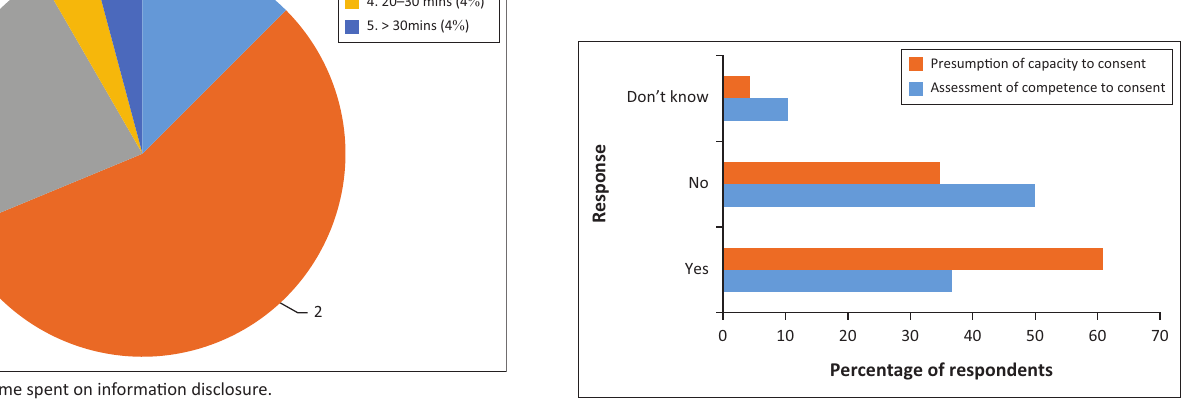
FIGURE 3: Presumption of capacity to consent and assessment of competence to consent in